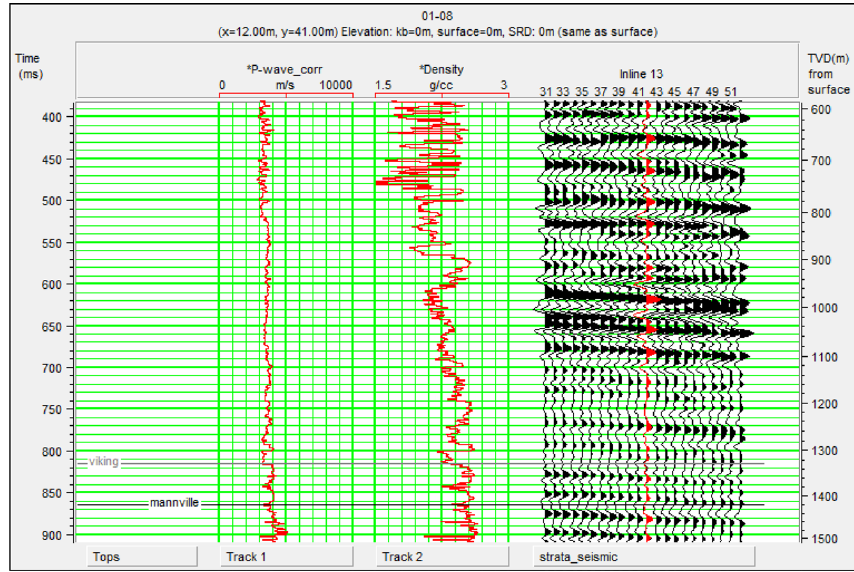
Fig. 9 Showing correlation of seismic and well log data by 90% in the well 8